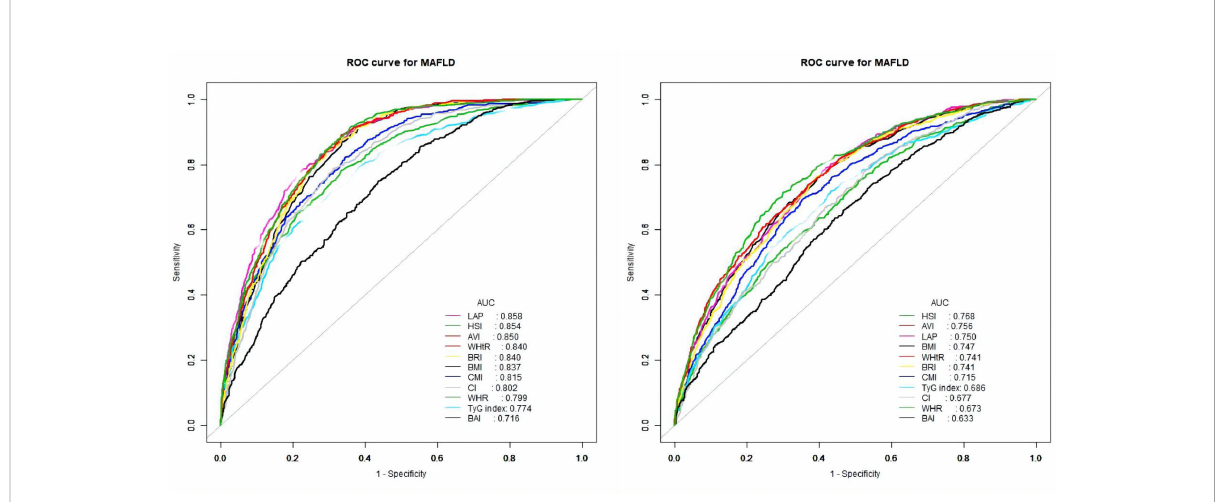
FIGURE 4 Receiver operator characteristic for anthropometric indices in diagnosing MAFLD strati fi ed by age [(left) 18 – 50 years and (right) >50